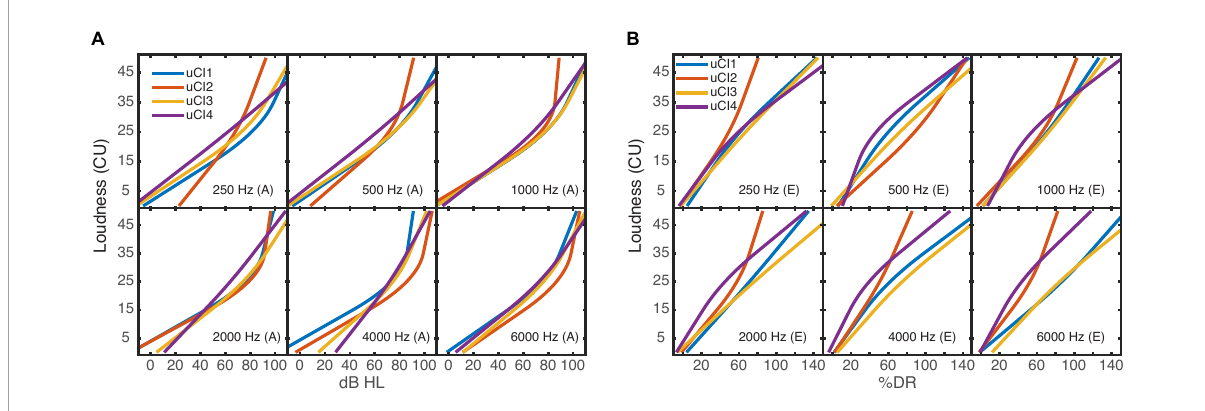
FIGURE3 Averaged loudness functions of the six narrowband noises for each of the four uCI listeners. (A) Shows the acoustical measurements; (B) the electrical measurements of each listener. The different x -axes (either dBHL or% DR) depend on the used domain. The stimulations of 0% DR and 100% DR corresponded to the listeners’ T- and M-level thresholds. It should be noted that the loudness functions can have a different range across listeners and electrodes due to individual U-levels ( > 100% DR) which were used as maximum presentation level.